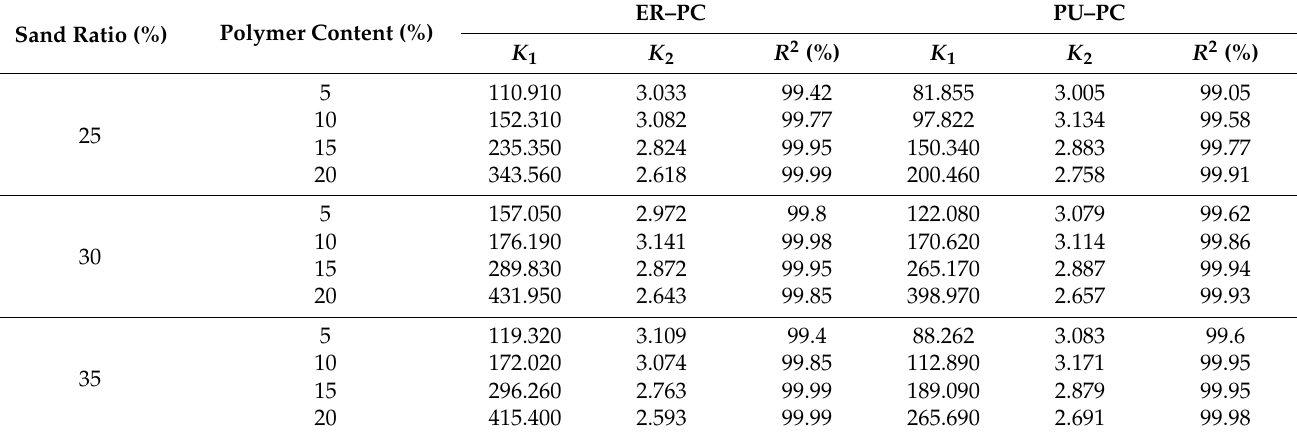
Table 5. Fitting results of σ - N fatigue